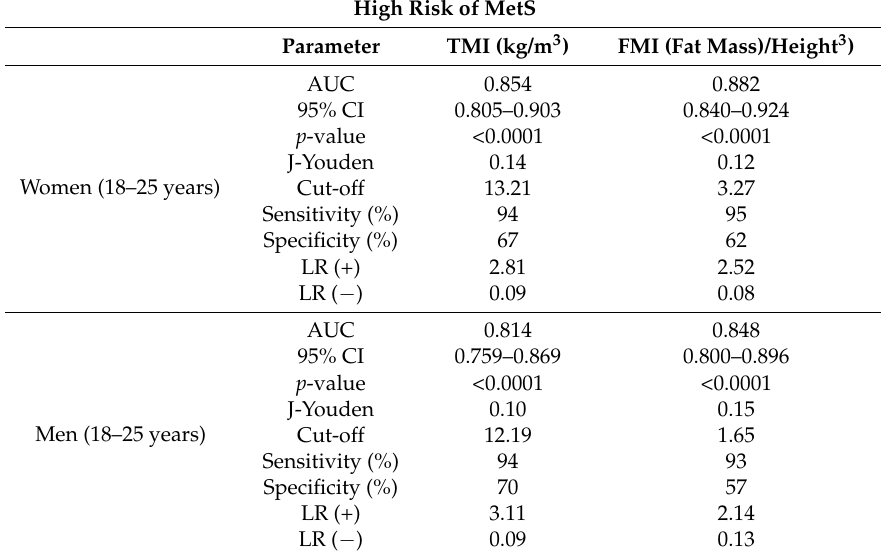
Table 4. Parameters of the receiver operating characteristic (ROC) curves analysis for the diagnostic performance of Tri-ponderal Mass (TMI) vs. fat mass index (FMI) in identifying high risk of metabolic syndrome (MetS) according to the International Diabetes Federation (IDF) criteria in men and